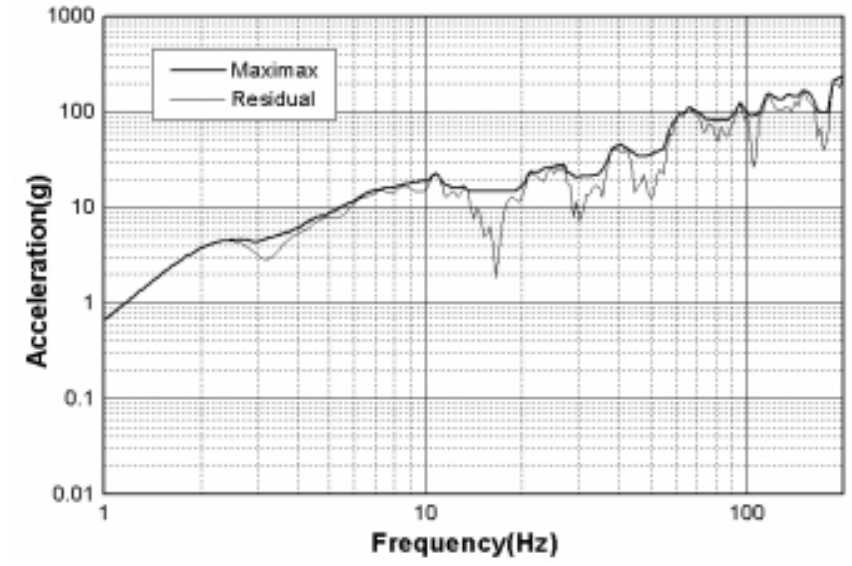
Fig. 9. Shock Response Spectrum at the foundation of main equipment.